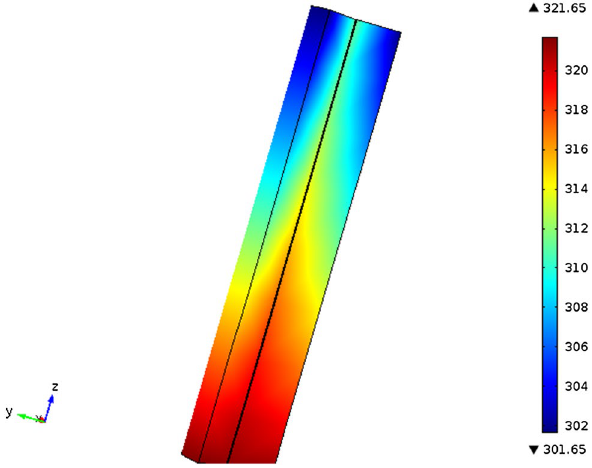
Fig. 3 Temperature field of whole well